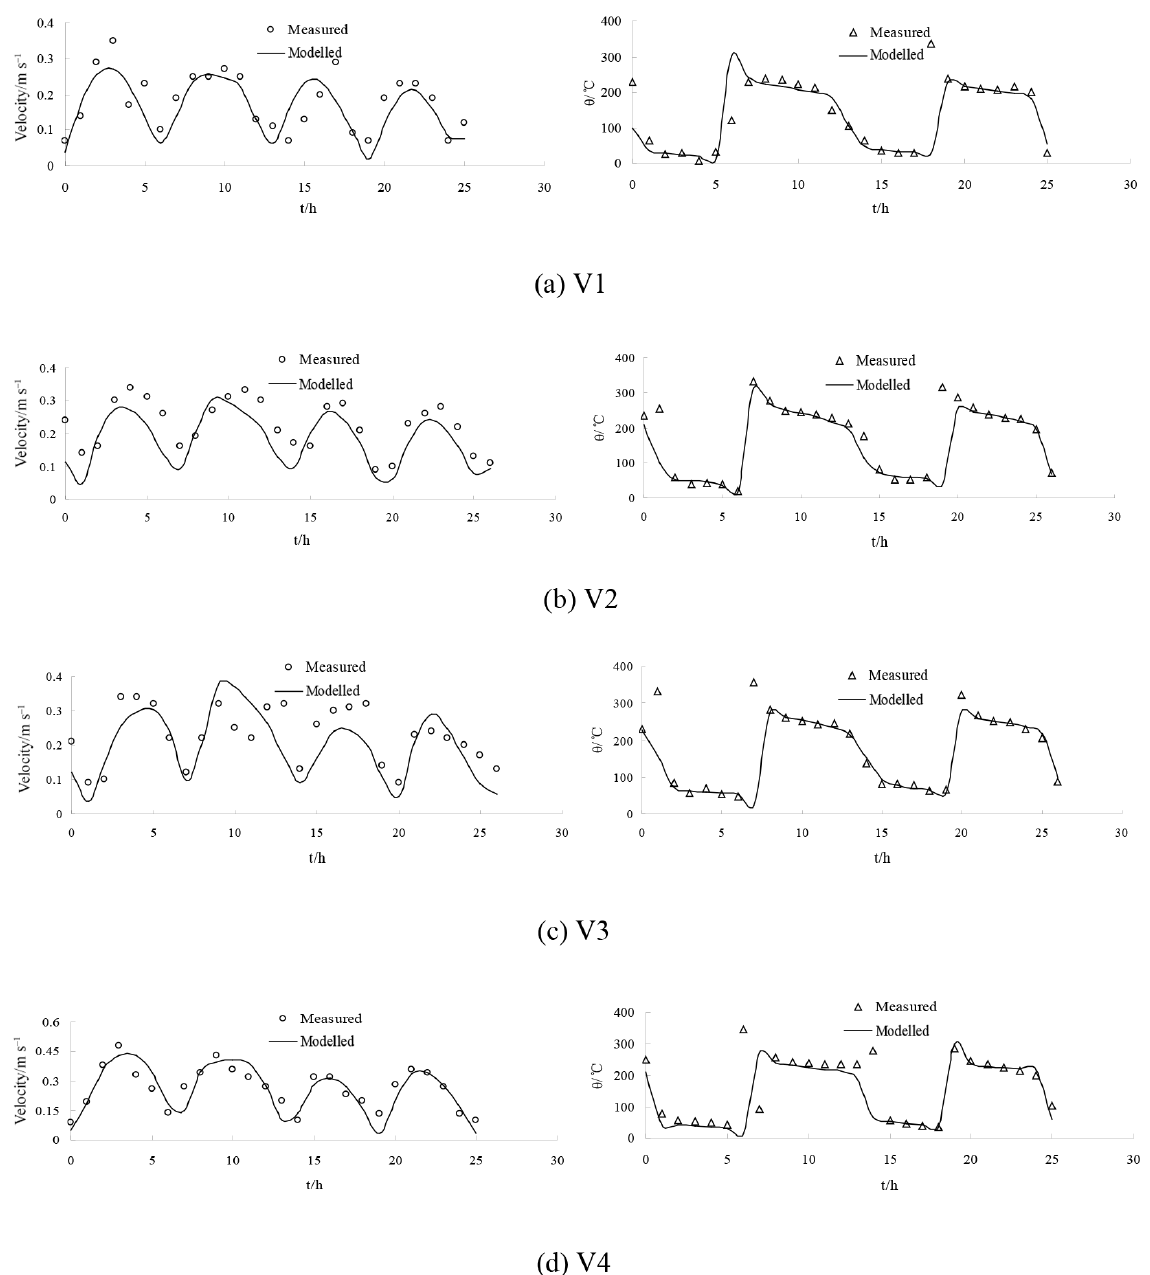
Figure 6. The validation of current speed (left side) and direction (right side) at measured stations during spring tide. Figures 7 and 8 show the flow field in flood and ebb tide during the neap and spring tide. During the flood tide, as depicted in Figs. 7a and 8a, the general flow of the tidal current well offshore is north-eastward. The main flow flooding into the Liao River divides to go around both sides of Gaizhou Shoal. When the flow reaches the east and north-east of the Gaizhou Shoal, the flow turns to the north-west, forming a mainstream flow from the outside sea into Liao River. West of the Gaizhou Shoal, the water mainly flows to the north and the north-east, and is affected by the delta terrain. During the spring tide period, the Gaizhou Shoal can be swamped by the tidal currents on both sides because of the high tide level. During the ebb tide period, as depicted in Figs. 7b and 8b, due to the development of many shoals, the current at the mouth of the estuary is divided into many branches. West of the Gaizhou Shoal, the current gradually turns from south-westward to southward. East of the Gaizhou Shoal, the tide current flows directly south-east and then turns to the south. Part of the Gaizhou Shoal is high enough to be exposed at the low tide. Overall, the modelled results are acceptable and the model can be used for the following studies. The results of the salinity validation for V1, V2, V3 and V4 between 29 and 30 May 2014 at spring tide are reported in Fig. 9. The model correctly estimates the salinity in the Liao River estuary. The measured salinities were obtained by a Sea-Bird 911 plus conductivity–temperature–depth (CTD)